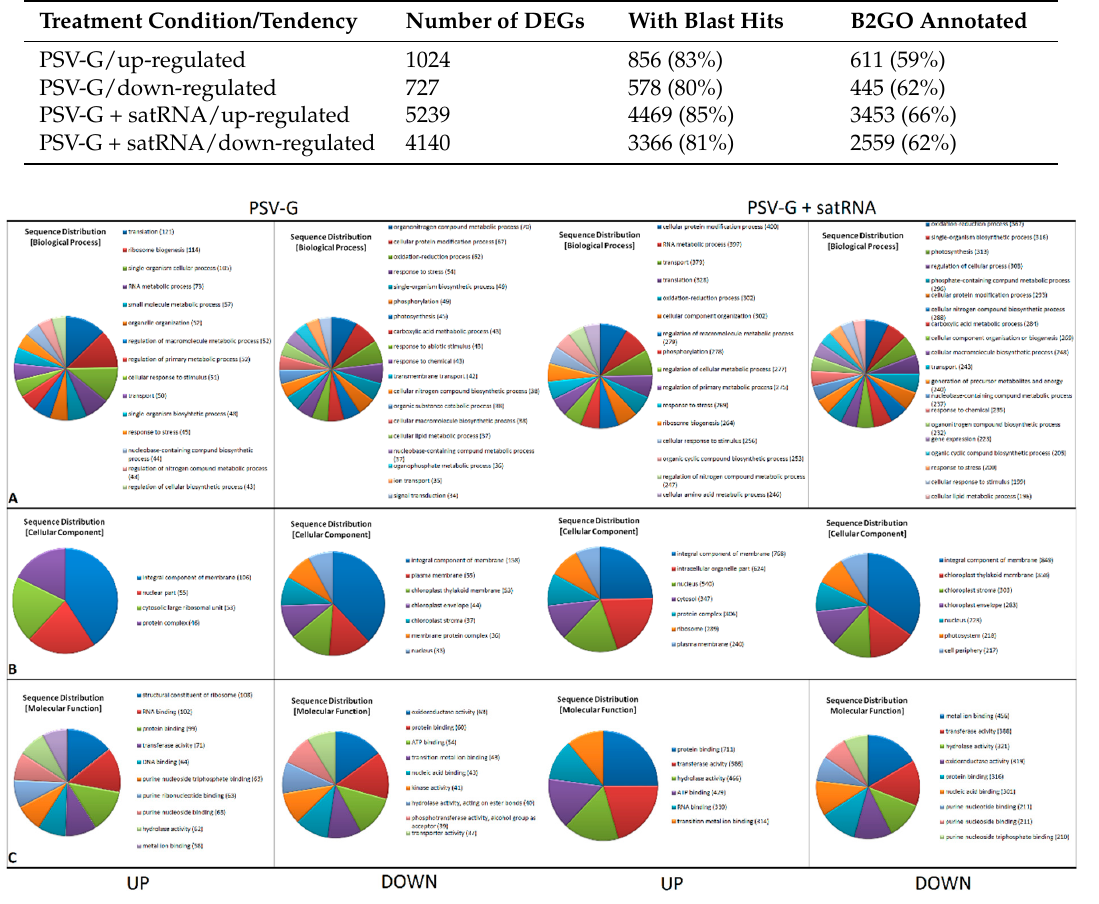
Figure 5. Gene ontology (GO) terms for differentially expressed genes (DEGs) of Nicotiana benthamiana infected with PSV or PSV + satRNA presented as multi-level pie charts. The distribution of GO terms was analyzed separately for up-regulated and down-regulated DEGs. ( A ) Biological Process; ( B ) Cellular Component; and ( C ) Molecular Function.